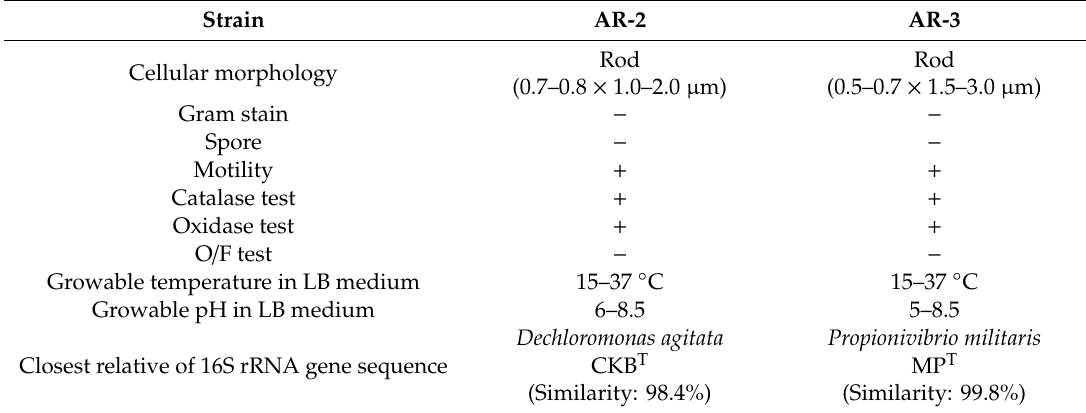
Table 1. Physiological and phylogenetic characteristics of strains AR-2 and